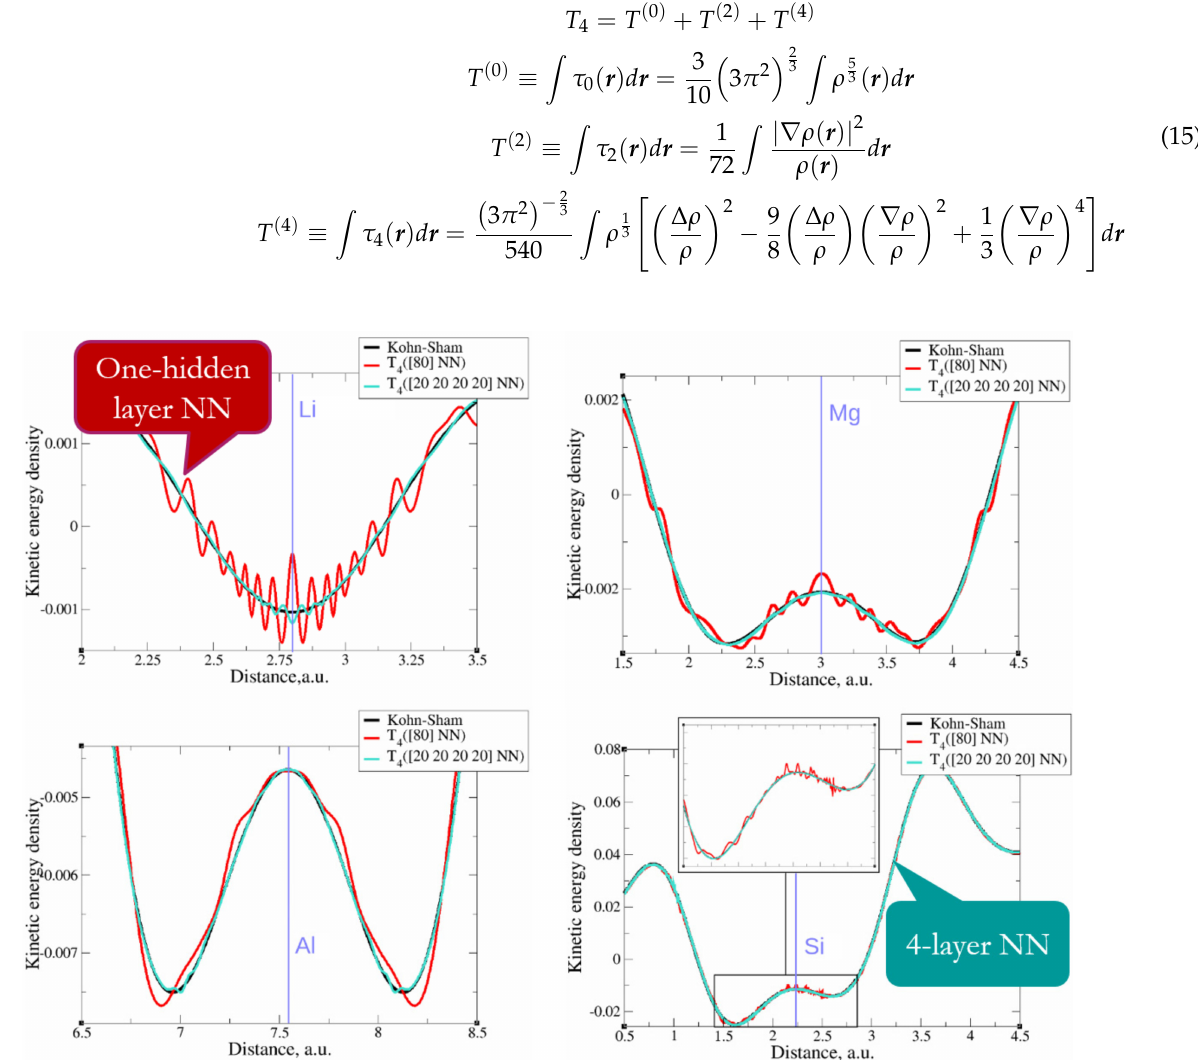
Figure 8. One-dimensional cuts of the kinetic energy densities of bcc Li (top left), hcp Mg (top right), fcc Al (bottom left), and cubic diamond Si (bottom right) along selected directions in the crystal lattice. The target Kohn–Sham kinetic energy density is shown as a black line, results of a single-hidden layer NN fit of the KEDs of all materials simultaneously with a red line (“[80] NN”, where 80 is the number of neurons in the hidden layer), and the results of a four-hidden layer NN fit of the KEDs of all materials simultaneously with a turquoise line (“[20 20 20 20] NN”, where 20 is the number of neurons in each hidden layer). See [78] for details. Adapted with permission from Ref. [78]. Copyright 2019 The Owner